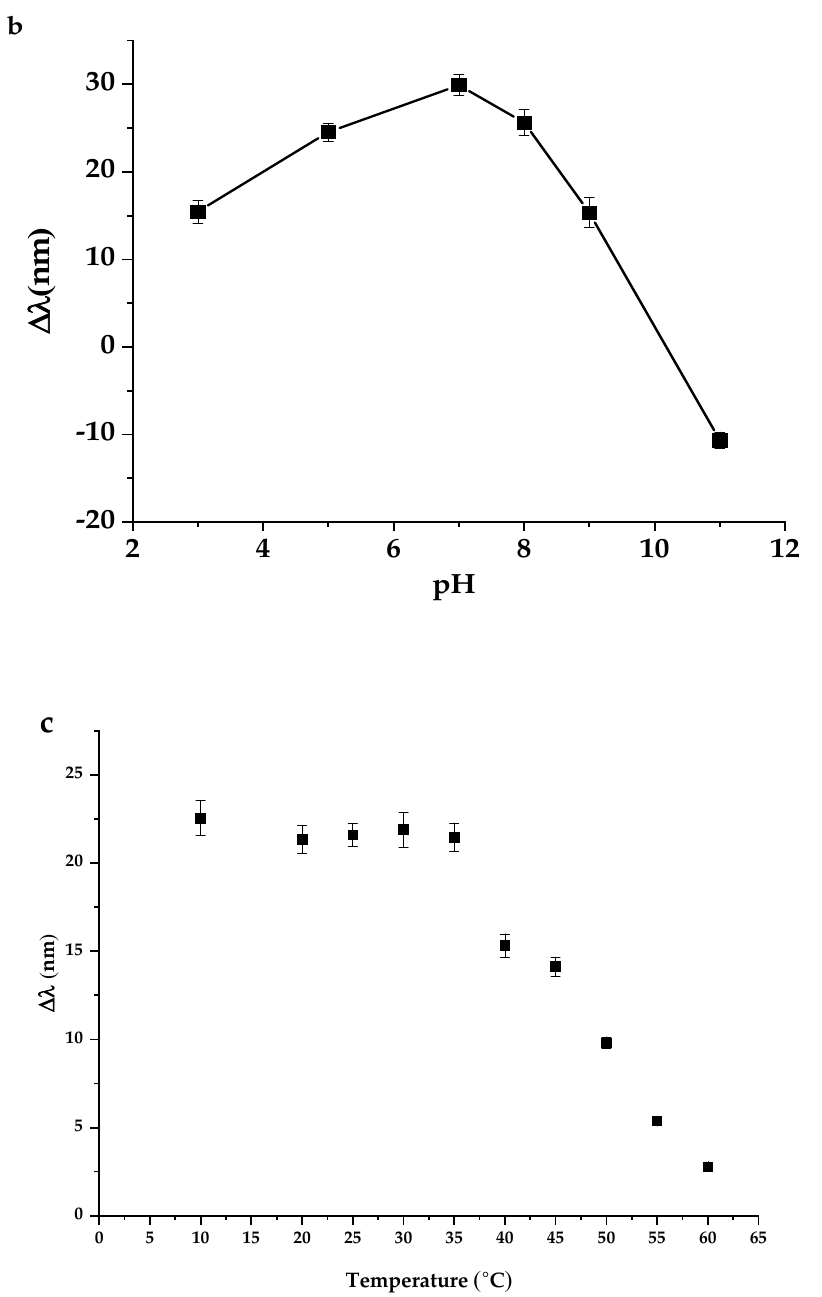
Figure 3. Effect of the methanol content in the assayed sample solution ( a ), pH ( b ) and temperature ( c ) on the MIPC signal (Concentration of BP: 0.001 mol · L − 1 ).